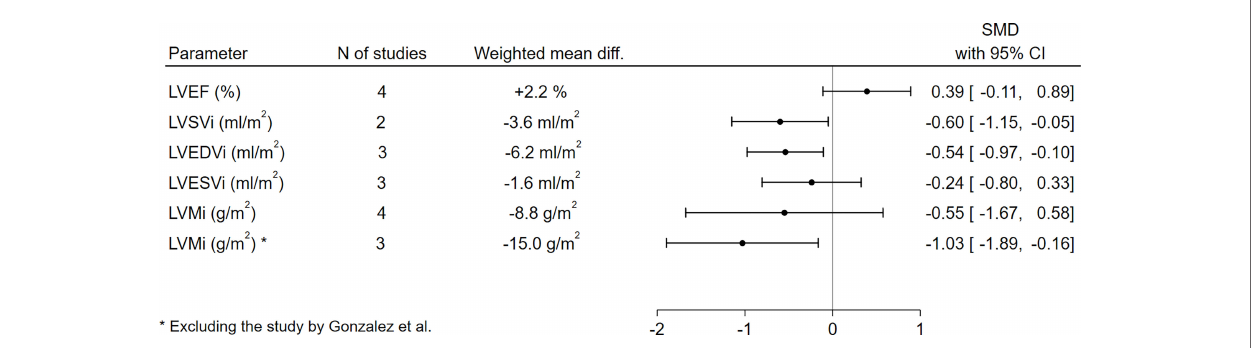
FIGURE 2 | Comparison of LV functional and morphological parameters between patients with GHD and controls. CI, con fi dence interval; GHD, growth hormone de fi ciency; LV, left ventricle; LVEDVi, left ventricular end-diastolic volume index; LVEF, left ventricular ejection fraction; LVESVi, left ventricular end-systolic volume index; LVMi, left ventricular mass index; LVSVi, left ventricular stroke volume index; N, number; SMD, standardized